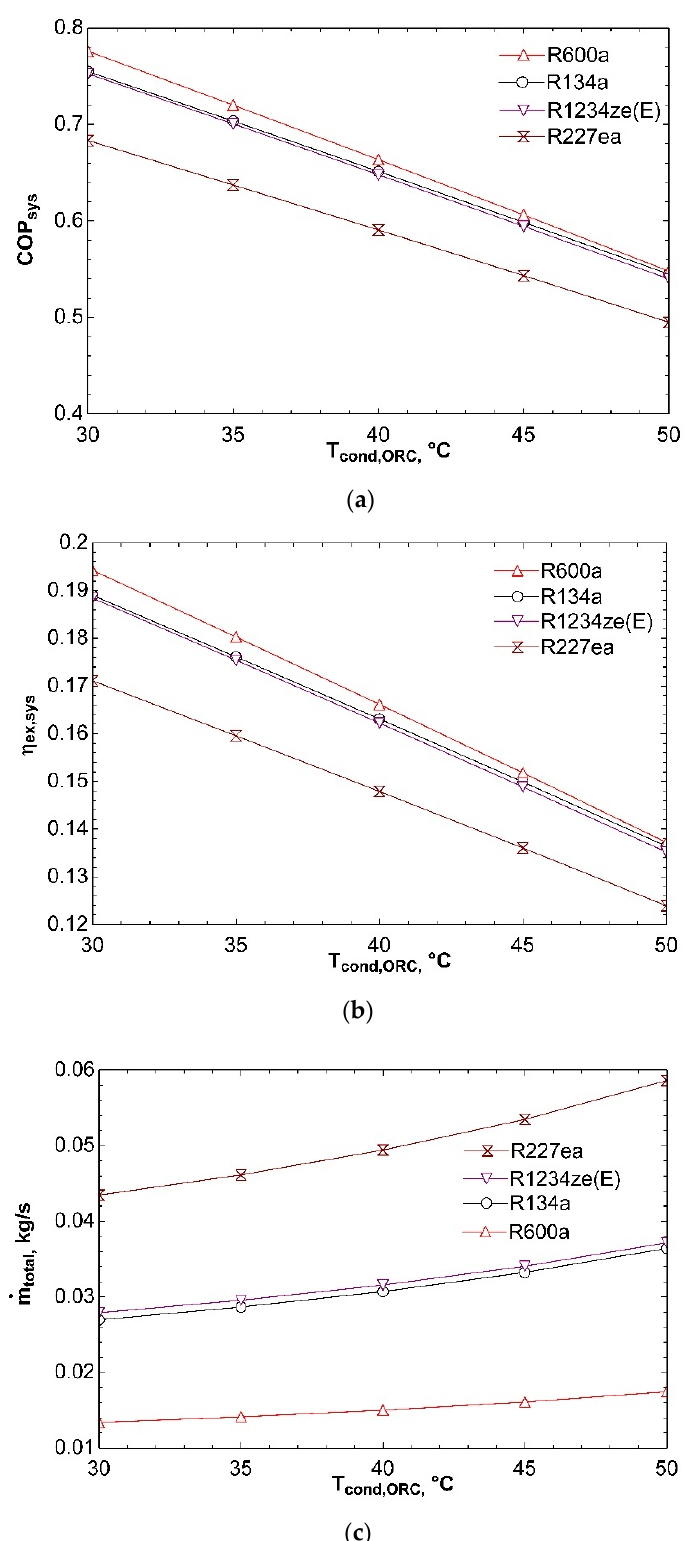
Figure 7. E ff ect of T cond,ORC on COP sys ( a ), η ex,sys ( b ), and ˙m total ( c ) in combined ORC-single evaporator Figure 7. Effect of T cond,ORC on COP sys ( a ), ƞ ex,sys ( b ), and ṁ total ( c ) in combined ORC-single evaporator Figure 7. Effect of T cond,ORC on COP sys ( a ), ƞ ex,sys ( b ), and ṁ total ( c ) in combined ORC-single evaporator VCR VCR cycle. VCR cycle.